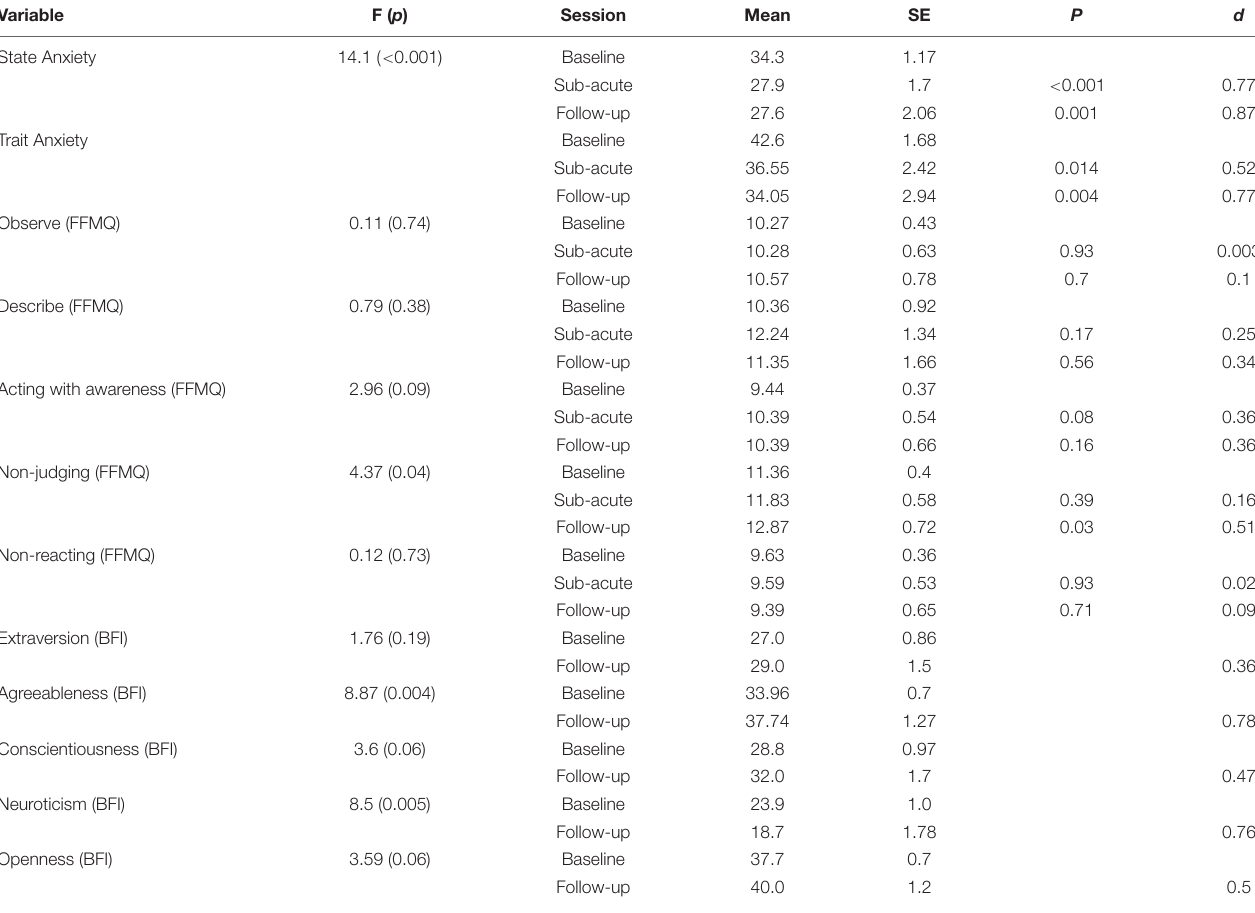
TABLE 1 | Summary of regression and contrast analyses of the dependent measures.